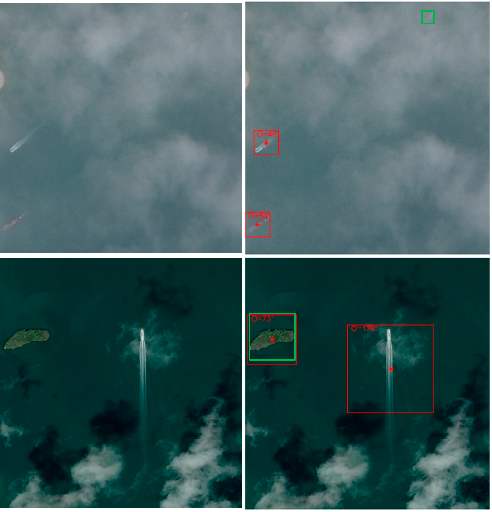
Figure 15. Two failed detection examples. Due to the small target size and low resolution of the ship, missed detection marked with the green box occurs in the first row. In the second row, due to the shape of the island similar to that of the ship, false detection marked with the green box occurs.